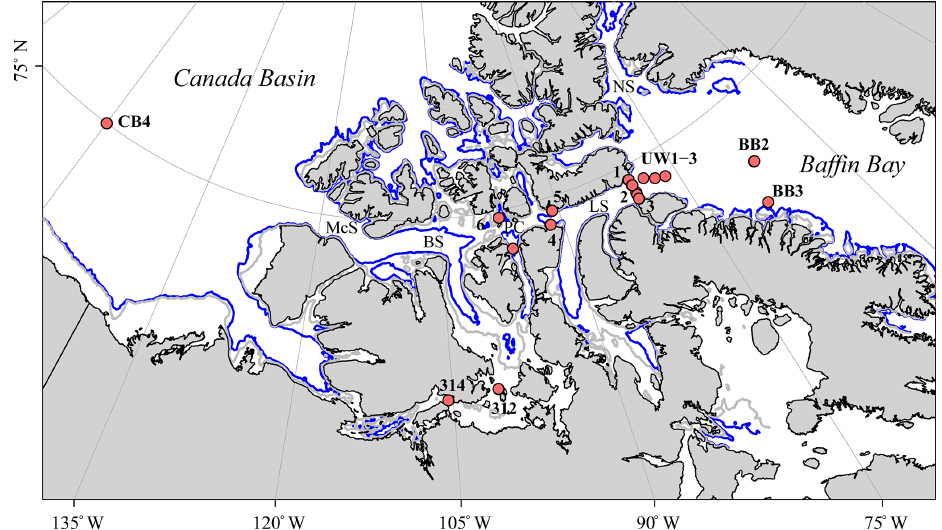
Figure 1. Map of the Canadian Arctic Archipelago (CAA) showing the 17 stations sampled during the 2015 GEOTRACES cruise aboard the CCGS Amundsen (red dots); the two unlabeled stations along the eastern CAA cross-channel transect are the surface stations 323 and 324, and the numbers refer to CAA stations (CAA1–CAA7). The Nares Strait (NS), Barrow Strait (BS), McClure Strait (McS), Lancaster Sound (LS), and Parry Channel (PC) are denoted, with the latter connecting the CAA from McS via BS to LS. Underway (UW) samples were taken on the way from Baffin Bay (BB) into Lancaster Sound. Finally, the blue and gray lines indicate the 200m and 100m isobaths,